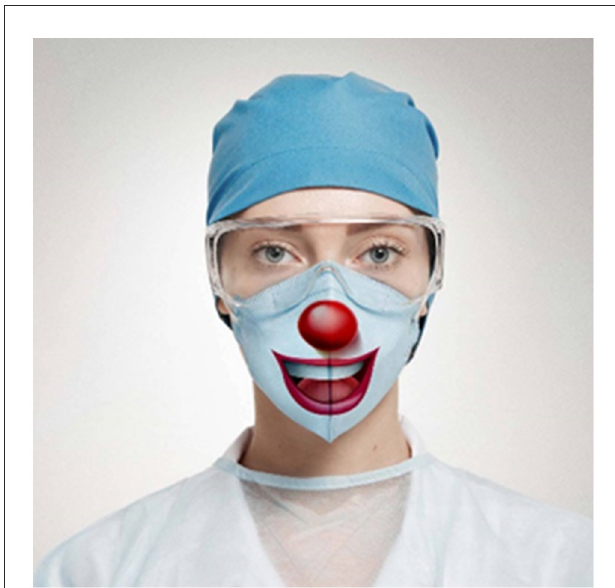
FIGURE1 As shown by this Research Topic, facemasks affect emotion recognition and social interaction. Yet people easily differentiate between true and social (fake, dishonest) smiles even when covered by facemasks. Better no smile at all than a fake smile (Pavlova and Sokolov, 2022a). Some attempts to diminish the negative effects, in particular, in the healthcare system, require special rigorous experimenting. The image (courtesy of Jyo John Mulloor, a digital artist) is reproduced with his written